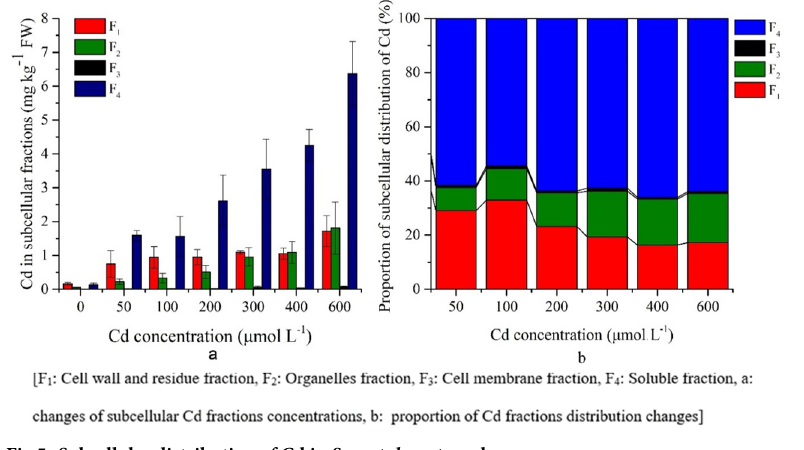
Fig 5. Subcellular distribution of Cd in S . portulacastrum